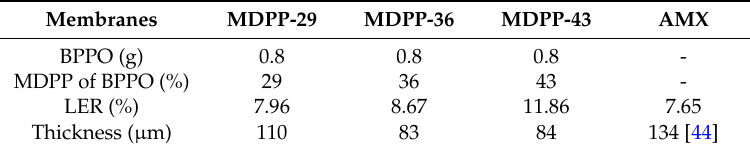
Table 1. Composition, linear expansion ratio (LER) and thickness of membrane MDPP-29 to MDPP-43.